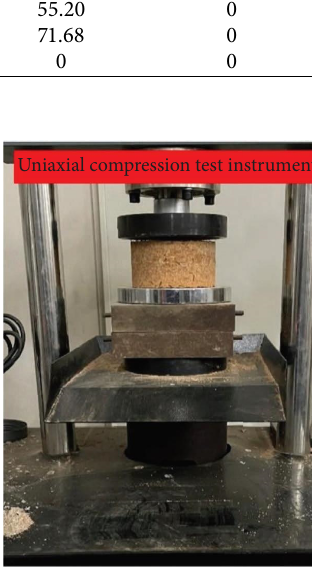
Figure 4: uniaxial compression test